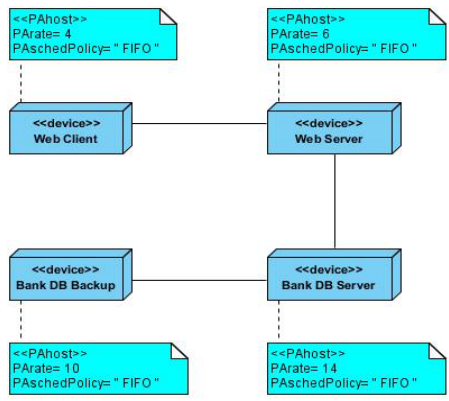
Fig. 5. The margined deployment diagram pertaining to the online shopping